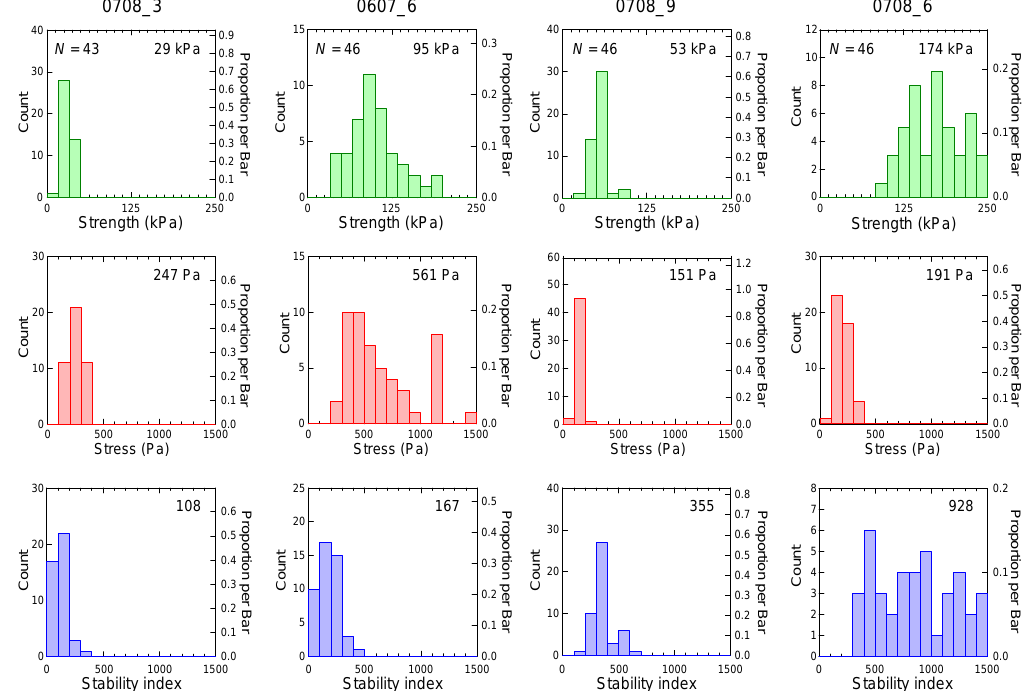
Figure 6. Exemplary distributions of strength, stress and stability index for four slopes (grids). Grids 0708_3 and 0607_6 are rather unstable whereas grids 0708_9 and 0708_6 are rather stable. Numbers indicate the median value. N varies between 43 and